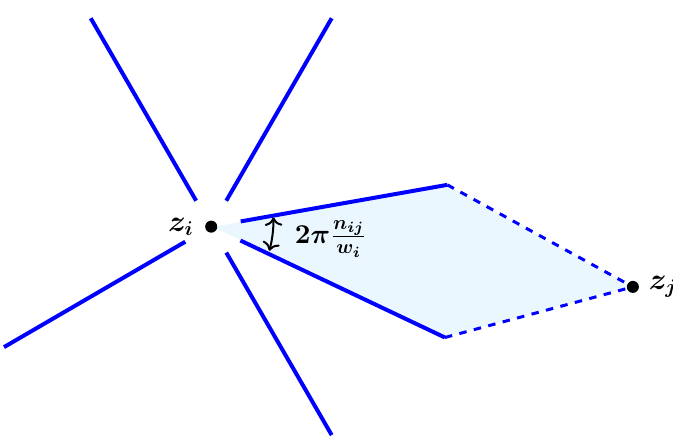
Figure 3 . The local neighbourhood near a double pole of the Strebel differential — where strips such as in figure 2 are glued together. Compare with the middle picture of figure